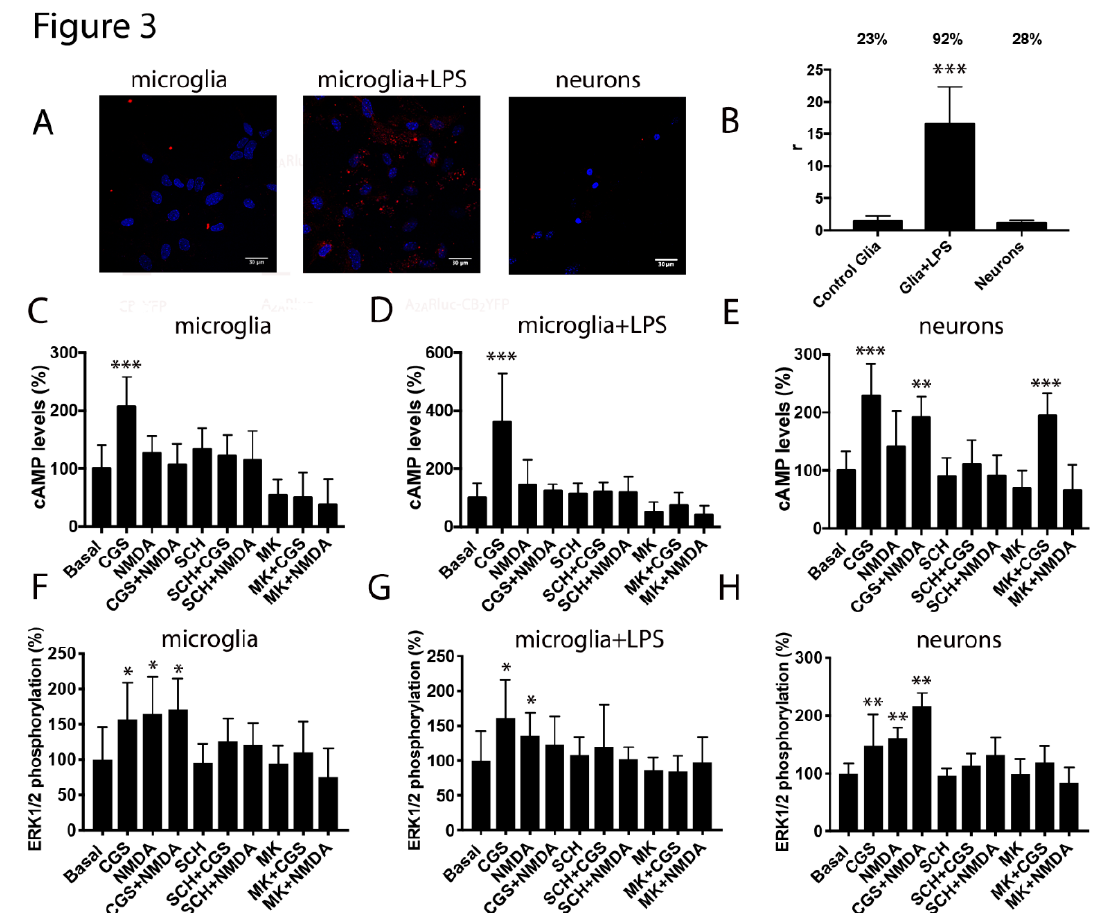
Figure 3. Expression and functionality of the A 2A and NMDA receptors heteromers in the microglial and neuronal primary cultures. Panels ( A , B ). The proximity ligation assay (PLA) was performed in mice microglial primary cultures treated or not with 1 µ M lipopolysaccharide (LPS) and 200 U / mL interferon- γ (IFN- γ ) to activate the microglia and in the mice hippocampal primary cultures of neurons using the primary antibodies specific for the A 2A and NMDA receptors. In all cases, the cell nuclei were stained with Hoechst (blue). The confocal microscopy images are shown (superimposed sections) in which heteromers appear as red clusters (in neurons or microglia). Scale bars = 30 µ m. The bar graph ( B ) shows the number of the red dots / cell (r) and the numbers above the bars indicate the percentage of cells presenting red dots. Values are the mean ± SEM ( n = 8). A one-way ANOVA followed by Bonferroni’s multiple comparison post-hoc test were used for statistical analysis (*** p < 0.001, versus control -resting- microglia). Panels ( C – H ) display the microglial primary cultures treated ( D , G ) or not ( C , F ) with 1 µ M LPS and 200 U / mL IFN- γ and the mice hippocampal primary cultures of the neurons ( E , H ) that were pre-incubated or not with 1 µ M of the A 2A R antagonist SCH-58261 (SCH) or with 1 µ M of the NMDAR antagonist MK-801 (MK) followed by treatment with 100 nM of the A 2A R agonist CGS-21680 (CGS), 15 µ M NMDA or both, and the cAMP levels ( C – E ) and ERK 1 / 2 phosphorylation signal ( F – H ) were determined. The values are the mean ± SEM of 10 to 12 di ff erent experiments. The ERK 1 / 2 phosphorylation levels and cAMP increases were expressed as a percentage over basal. A one-way ANOVA followed by a Bonferroni multiple comparison post-hoc test showed a significant e ff ect over 100% (* p < 0.05, ** p < 0.01, *** p < 0.001).